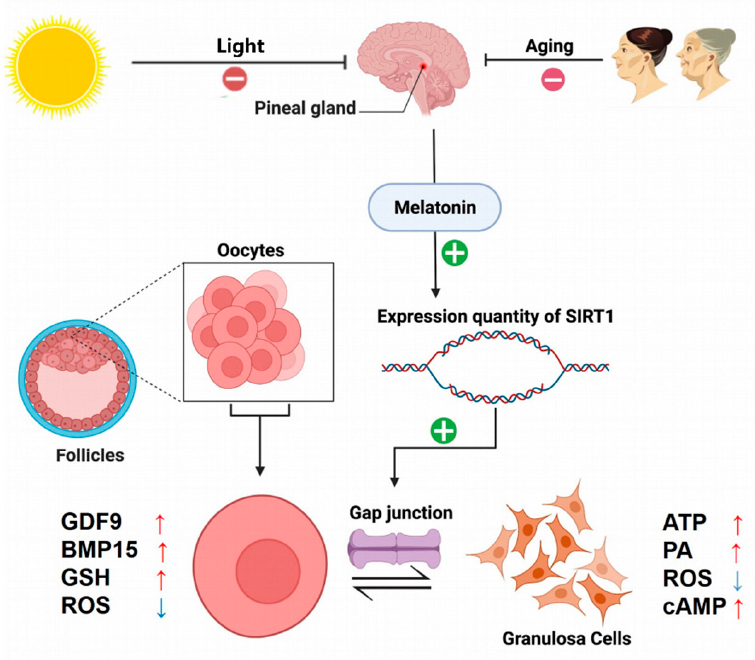
Figure 4. Regulatory effect of SIRT1 on cell gap junctional communication in ovarian granulosa